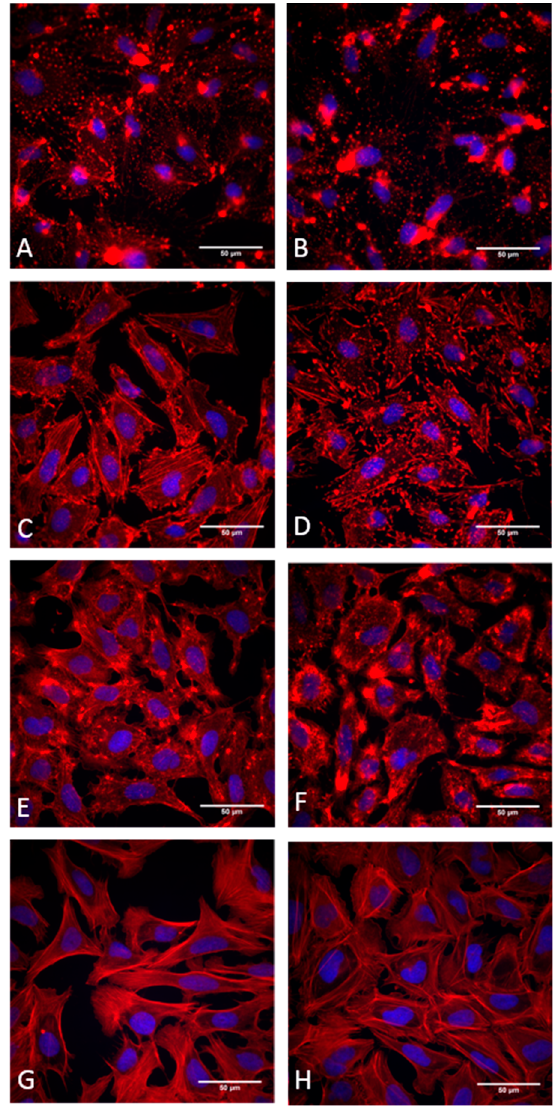
Figure 2. Immunofluorescence staining with phalloidin of U2OS cells treated with cytochalasans. ( A ) Treated with 1 µ M cytochalasin H ( 8 ). ( B ) Treated with 5 µ M cytochalasin H. ( C ) Treated with 1 µ M cytochalasin B ( 4 ). ( D ) Treated with 5 µ M cytochalasin B. ( E ) treated with 1 µ M chaetoglobosin D ( 25 ). ( F ) Treated with 5 µ M chaetoglobosin D. ( G ) Treated with 5 µ M DMSO (negative control). ( H ) Washout after treatment with 5 µ M cytochalasin H.